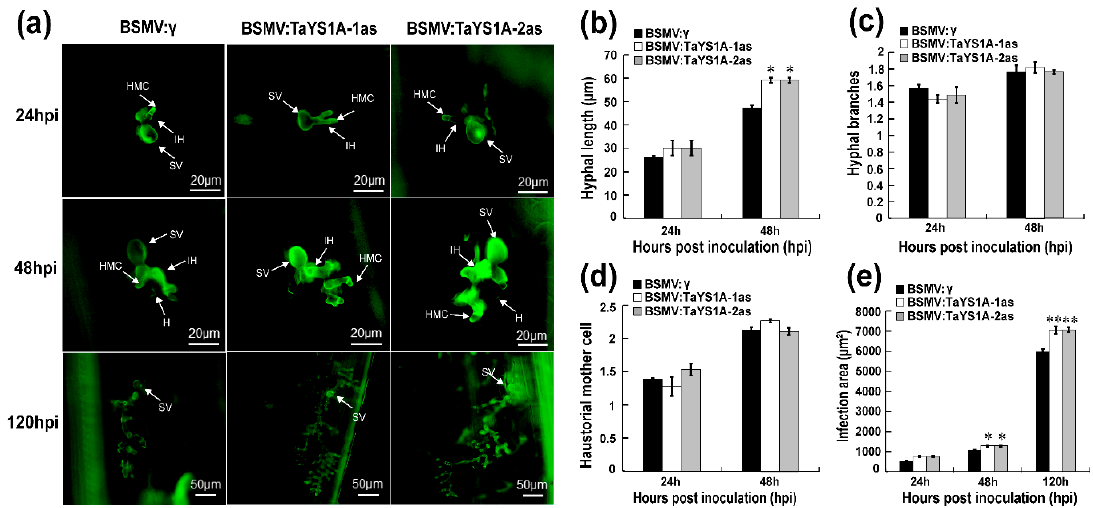
Figure 4. Histology of Pst avirulent race CYR23 in TaYS1A -silenced leaves. ( a ) Wheat germ agglutinin (WGA) was used to visualize fungal structures in wheat leaves infected with BSMV and Pst and the fungal structures were observed under an autofluorescence microscope. SV, sub-stomatal vesicle; HMC, haustorial mother cell; IH, infection hypha. H, haustoria. ( b ) Hyphal length is the average distance to the tip of the hypha from the intersection of the sub-stomatal vesicle and the hypha and was measured using DP-BSW (units in µ m) program (Olympus Corporation, Tokyo, Japan). ( c ) The average number of hyphal branches was estimated for each infection site. ( d ) The average number of haustorial mother cells in each infection site was determined. ( e ) Infection area is the average of developing hyphae, and was measured using the DP-BSW program (units in µ m 2 ). All findings were derived from three biological repetitions and each replication considered 50 sites of infection. Asterisks ( p < 0.05) or double asterisks ( p < 0.01) designate significant di ff erences compared to the control plants at the same time points, using the Student’s t